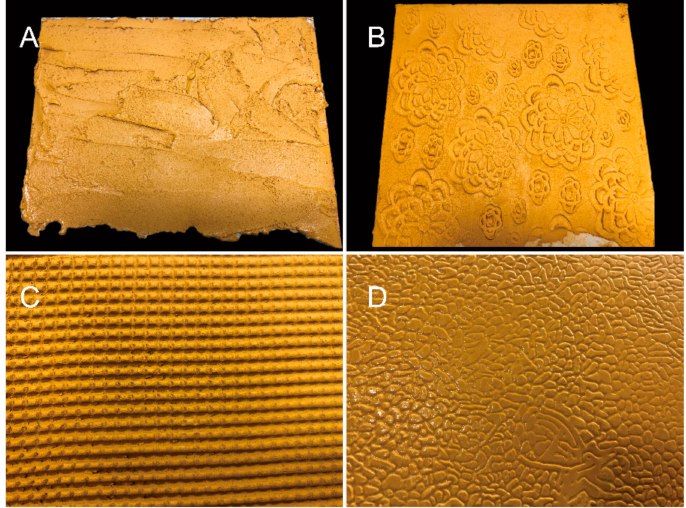
Figure 11. Picture to illustrate the applicable test of coating. ( A ) coating after being scraping, ( B , C , D )